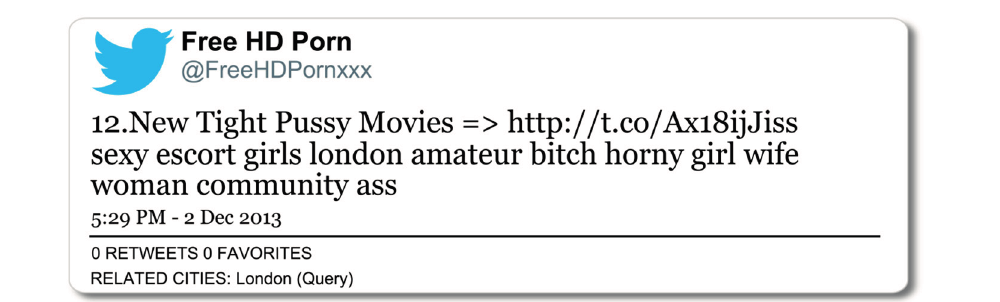
Figure 3. Example of a spam